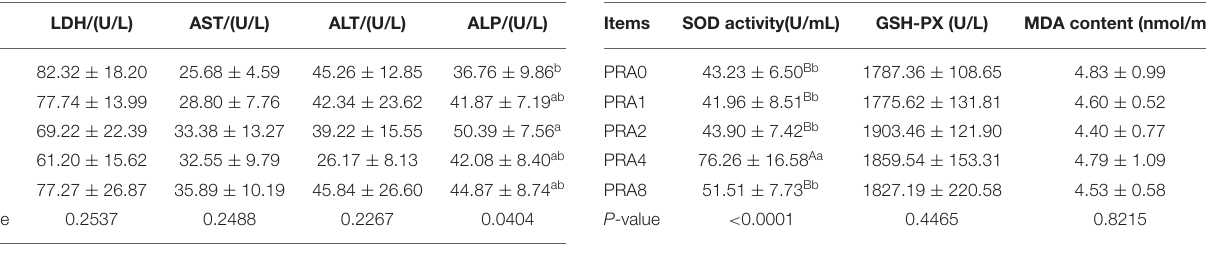
TABLE 6 | Effects of dietary PRA extract levels on serum antioxidant indexes of raccoon dog.